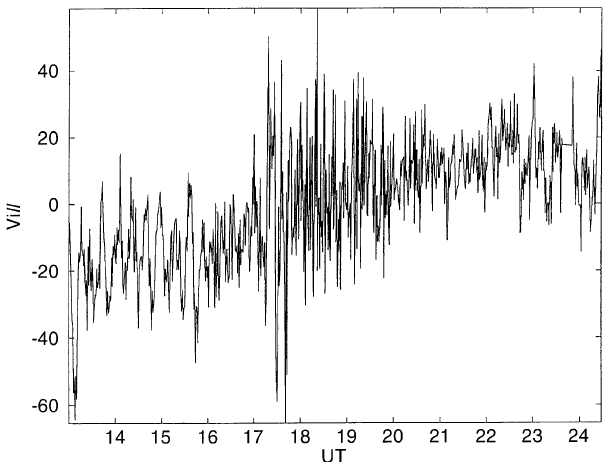
Fig. 8. Ion velocity (ms (cid:126)(cid:49) ) at 190.5 km for the 24 March 1995 experiment